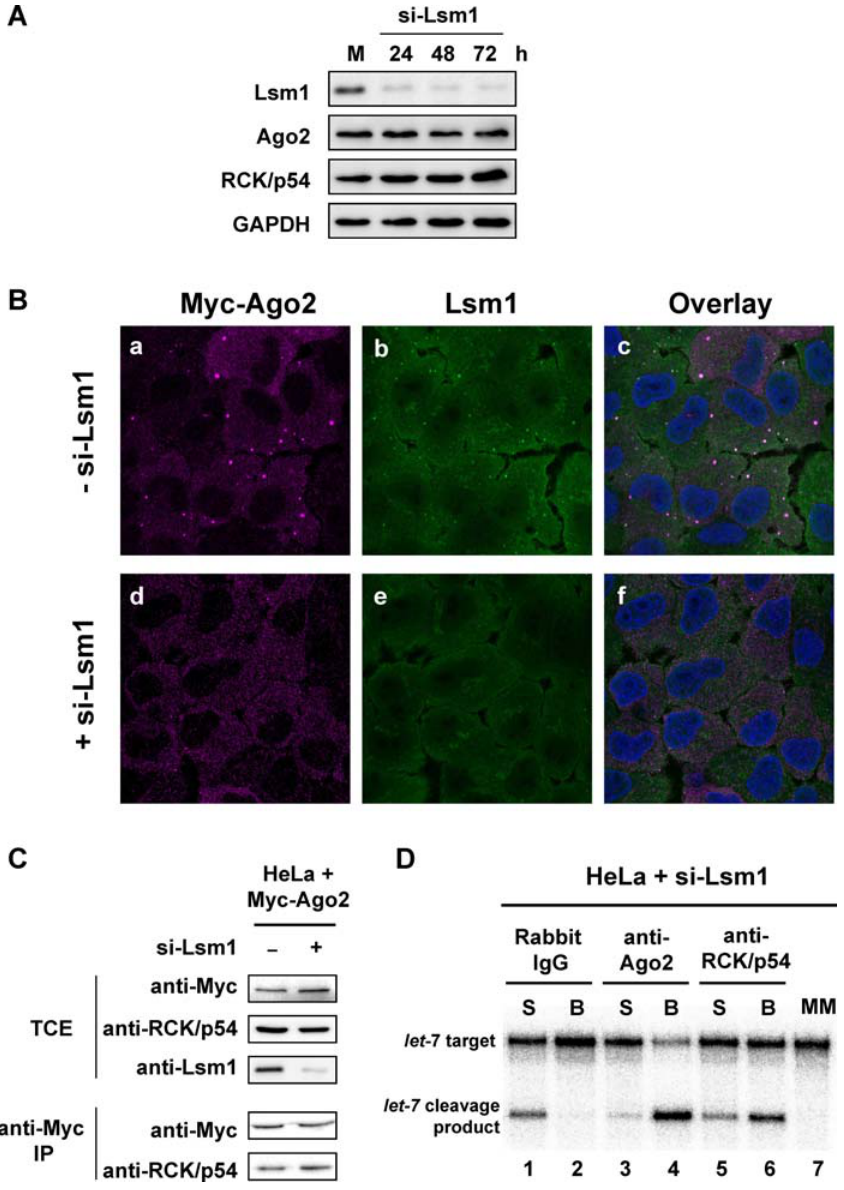
Figure 5. Depletion of Lsm1 Disrupts P-Bodies but Does Not Affect the Interaction between RCK/p54 and Ago2 (A) Specific knockdown of Lsm1 in HeLa cells by siRNA. HeLa cells were transfected with siRNA against Lsm1 and harvested at 24, 48, and 72 h post- transfection, and TCEs were analyzed by immunoblot with antibodies against Lsm1 or GAPDH. (B) Depletion of Lsm1 disrupts P-bodies. HeLa cells were transfected with siRNA against Lsm1. At 48 h post-transfection, cells were analyzed by immunofluorescence using antibodies against Lsm1 and Myc tag for Ago2. Cells were stained with Hoechst33258 to visualize nuclei, and images were digitally merged. (C) RCK/p54 interacts with Myc-Ago2 in Lsm1-depleted cells. HeLa cells were transfected for 48 h with Myc-Ago2 and control siRNA or siRNA against Lsm1, TCEs were prepared, and Myc-Ago2 was immunoprecipitated from an aliquot of TCE. TCE and anti-Myc IPs were analyzed by immunoblot using anti-Myc, anti-RCK/p54, and anti-Lsm1 antibodies. (D) Affinity-purified RCK/p54 and Ago2 from Lsm1-depleted cell extracts retain miRISC activity. HeLa cells were transfected for 48 h with siRNA against Lsm1, and cytoplasmic extracts were prepared. These extracts were incubated with magnetic protein A beads coupled with rabbit IgG, rabbit anti-Ago2, or rabbit anti-RCK/p54 antibodies to purify miRISC associated with RCK/p54. After immunoprecipitation, RISC activities were analyzed by incubating the supernatant (S) or bead (B) phases with 182-nt 32 P-cap-labeled let -7 substrate mRNAs having a perfectly matched or a mismatched sequence to the let- 7 miRNA. Cleavage products were resolved on 6% denaturing polyacrylamide gels. MM,